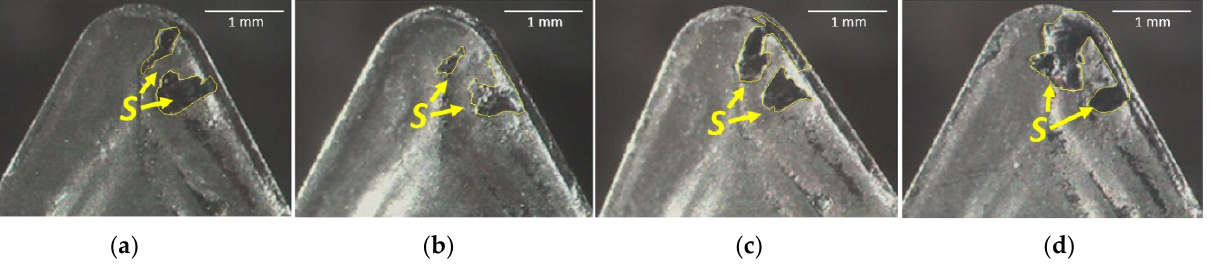
Figure 9. S measurement on the tool rake face for v c = 40 m/min and f = 0.10 mm/rev; ( a ) R1; ( b ) R2; ( c ) R3; ( d ) R4.